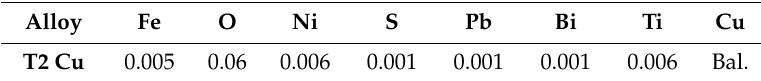
Table 2. Chemical composition of T2 Cu